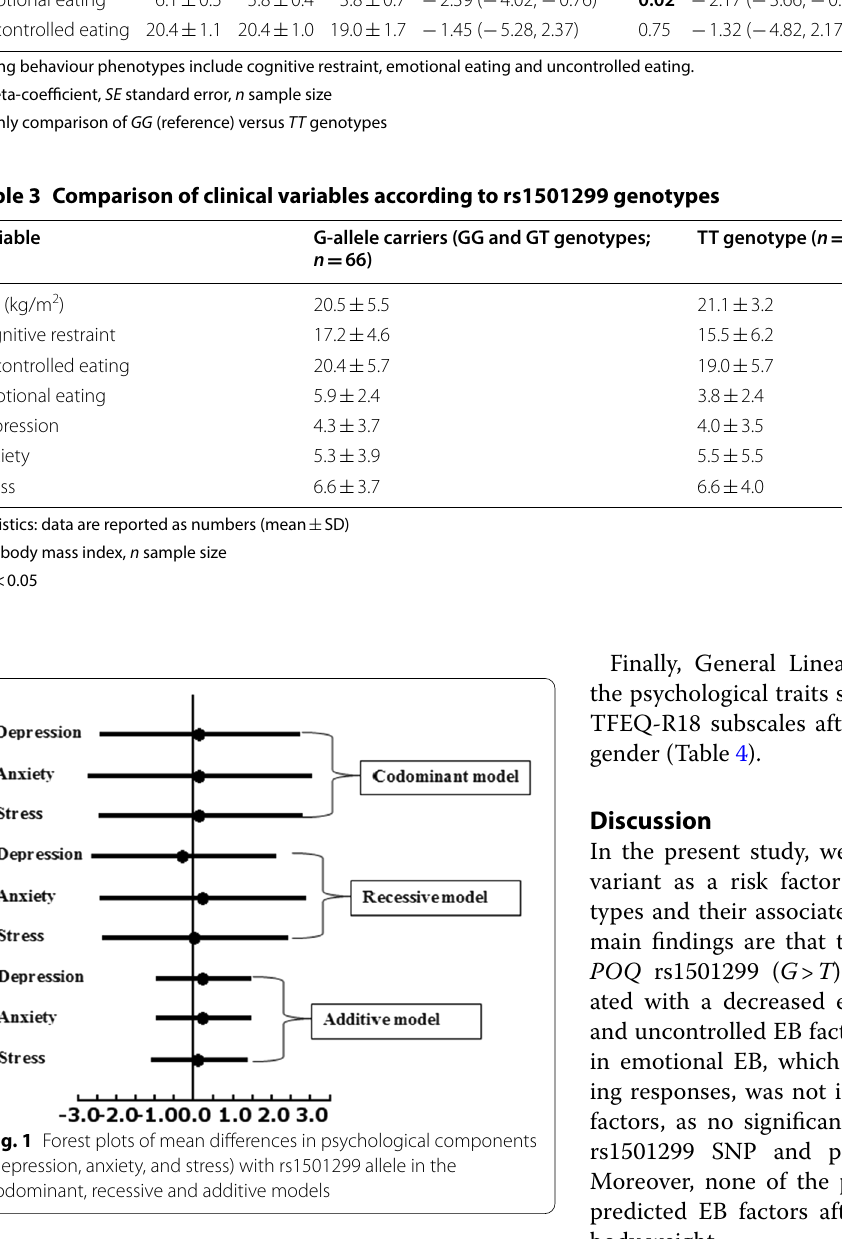
Table 2 Distribution of rs1501299 genotypes according to the 3 eating behavioural scales Scales